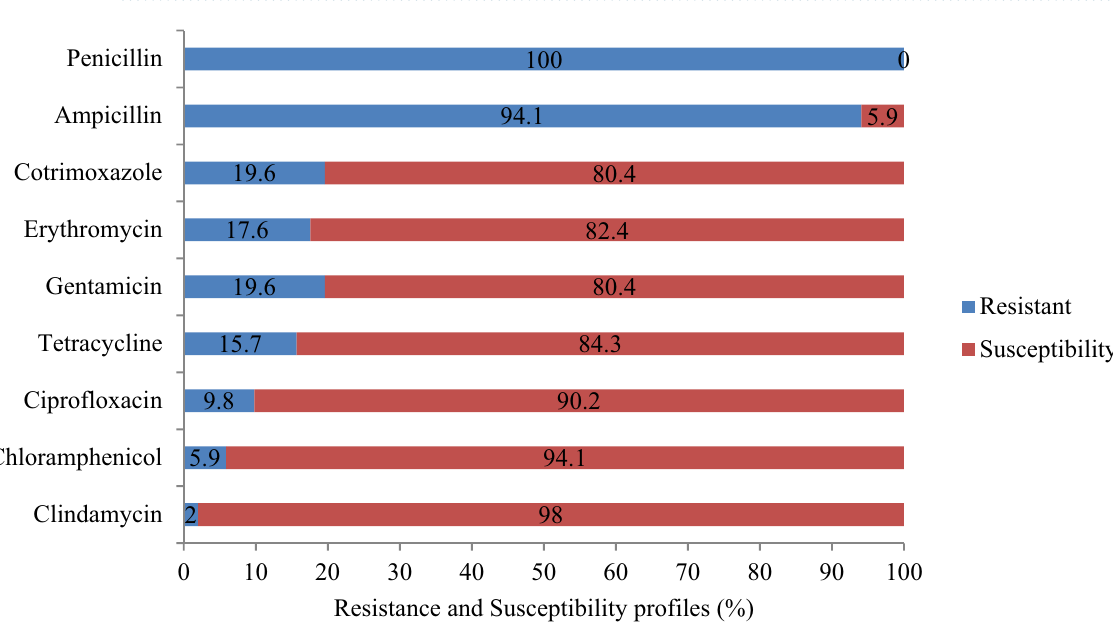
Figure 2. Antimicrobial susceptibility profiles of nasal MSSA isolates among Medicine and Health Science Students of Arba Minch University, Arba Minch, southern Ethiopia,